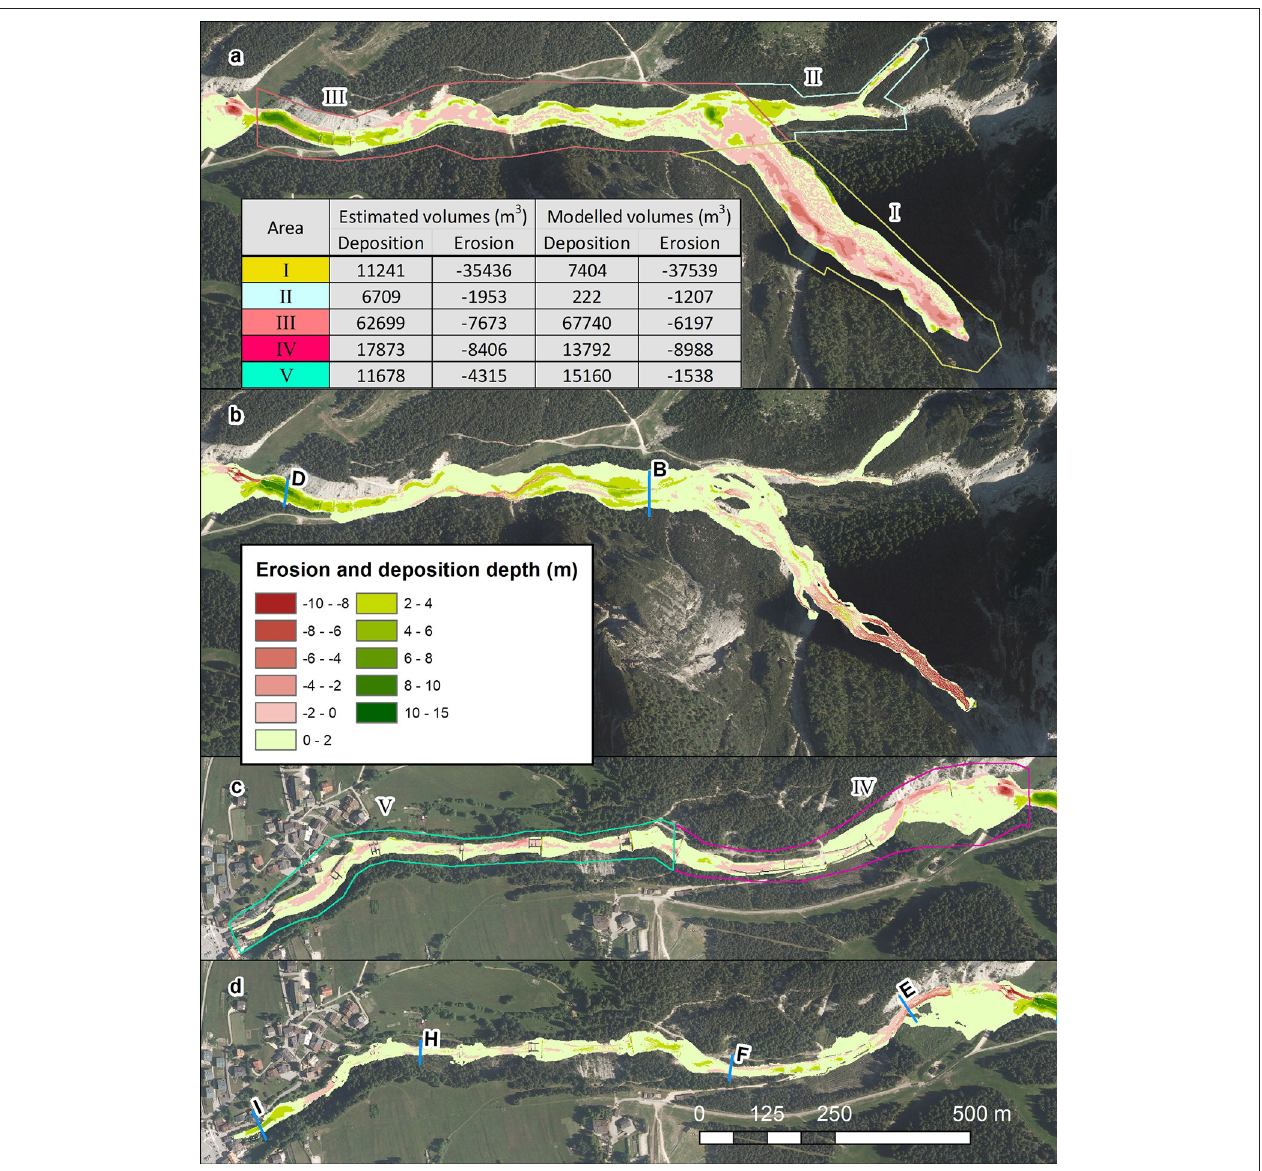
FIGURE 9 | Deposition and erosion depths map for the two groups of reaches. Upper image (a) is the map of estimated deposition and erosion for the reaches I-III, while the image below (b) is that simulated. Images (c,d) are the corresponding of (a,b) for the reaches IV-V respectively. The position of the six sections (B, D, E, F, H, and I) is also